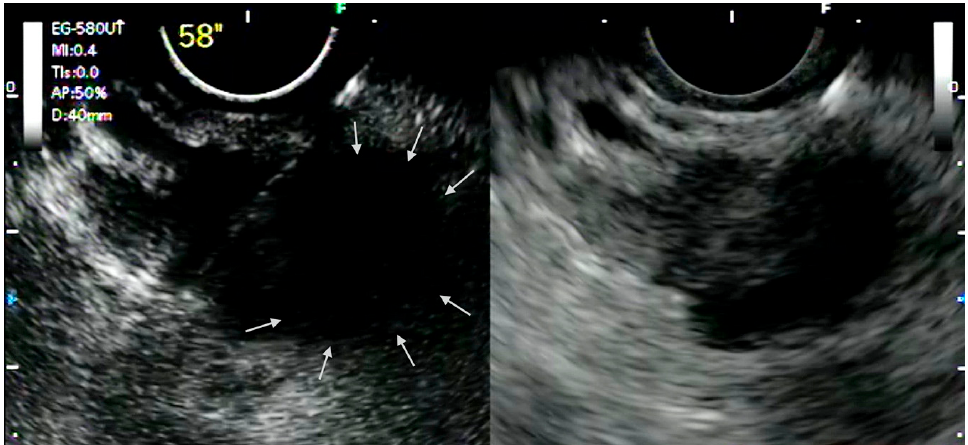
Figure 1. CH-EUS-guided tissue acquisition. View of a CH-EUS-guided FNB of a solid pancreatic lesion with the needle directed to avoid the area without enhancement (arrows).